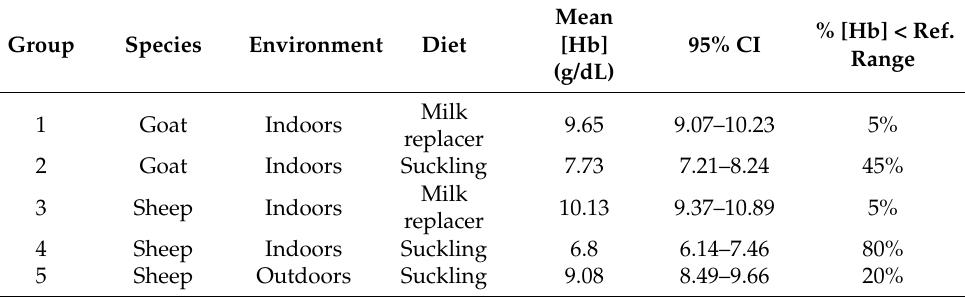
Table 2. Mean haemoglobin concentrations of the tested groups of lambs and kids from the prelimi- nary study. The 95% confidence interval is also shown, as is the percentage of animals in each group with a haemoglobin concentration below the reference range of 8–14